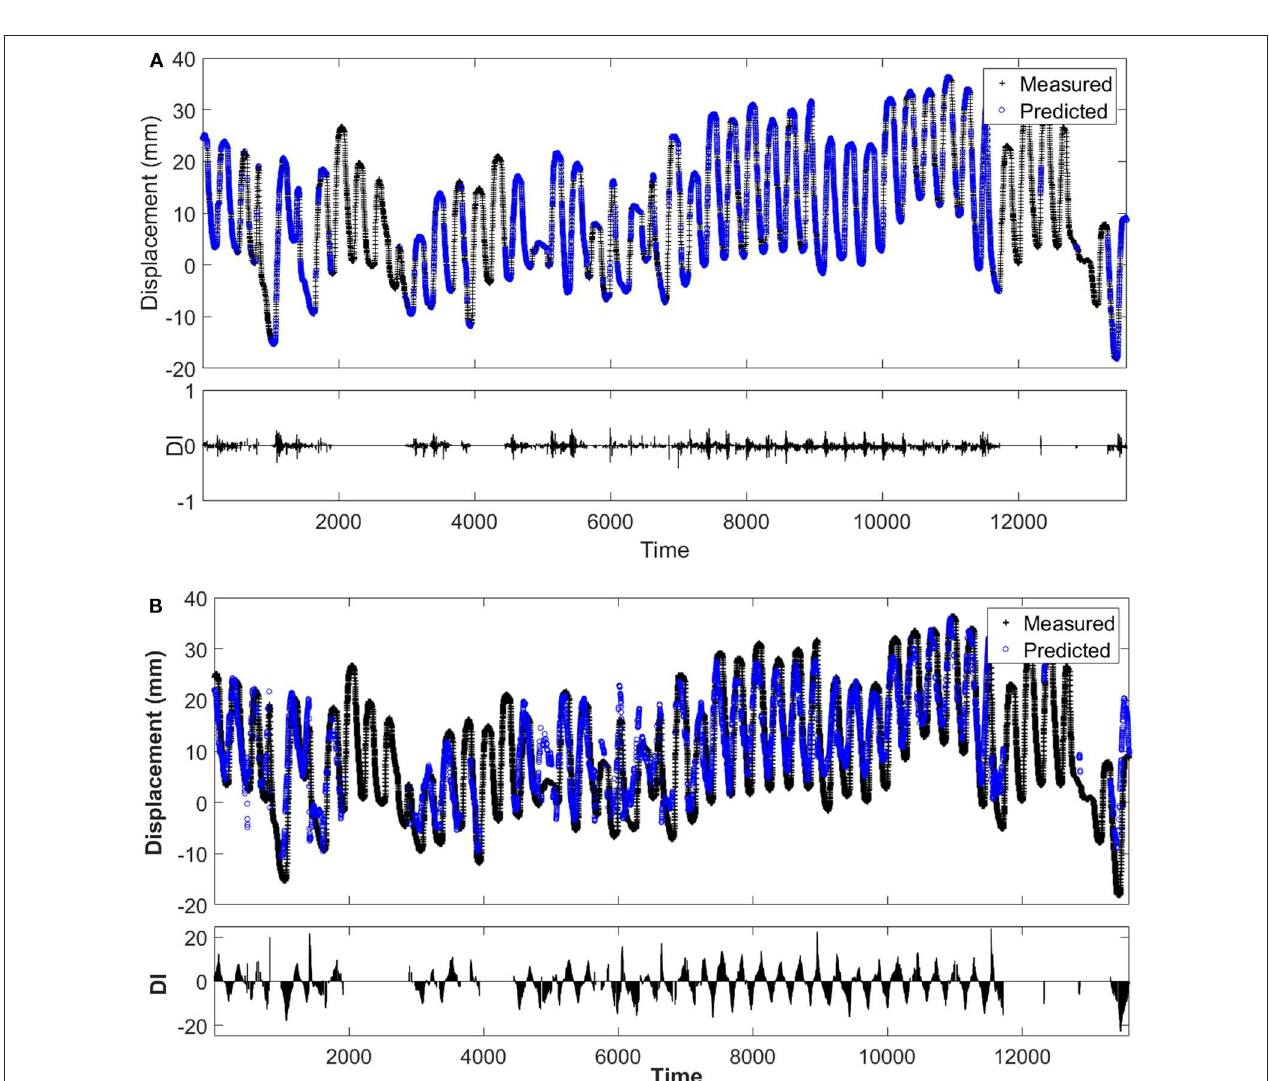
FIGURE 13 | (A) Pier A measured and ANN predicted results and (B) Pier A measured and conventional SHM baseline results.